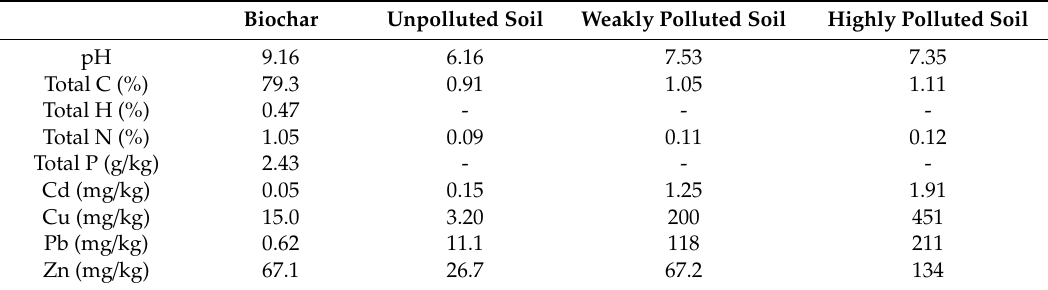
Table 1. Composition of Miscanthus biochar used for soil amendment and soils used in the pot experiment.